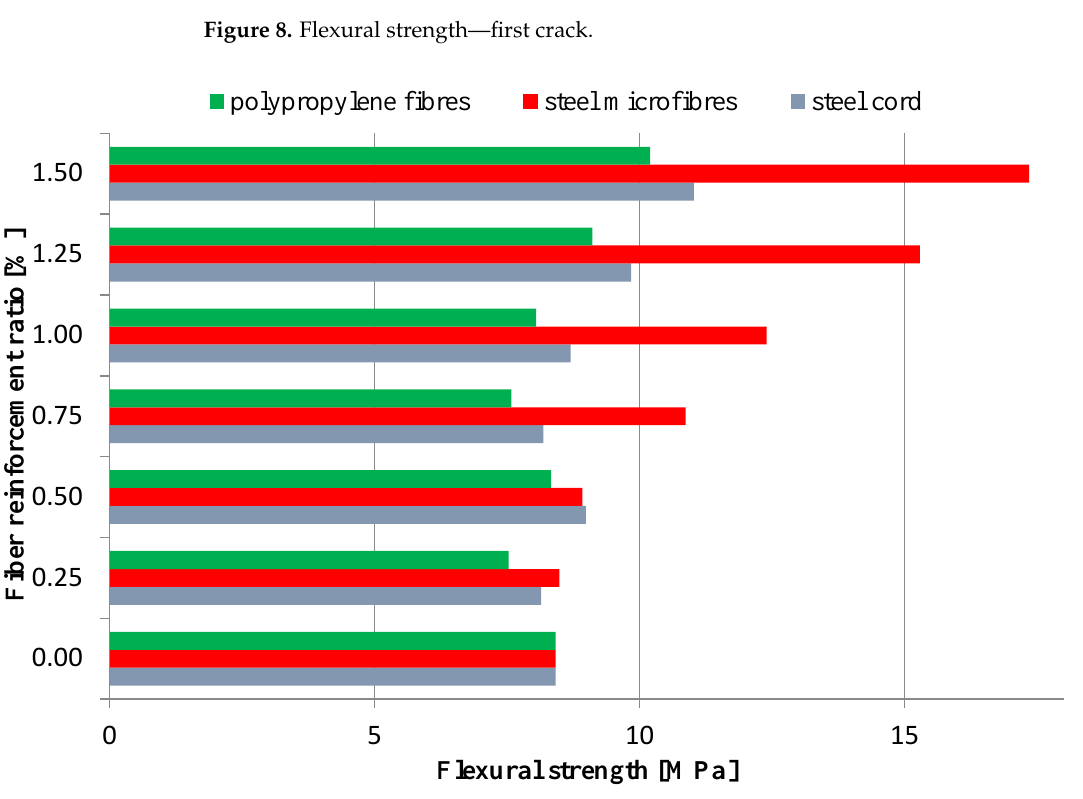
Figure 9. Flexural strength.